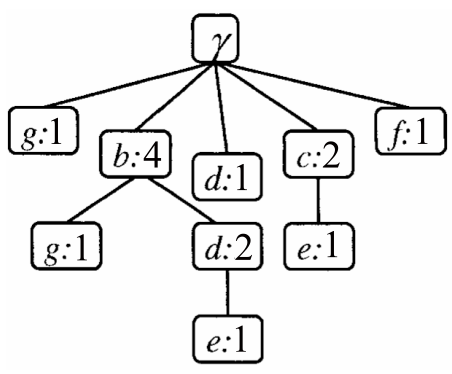
Fig. 5 Example of a tree storage sub-trajectory based on compression [43]